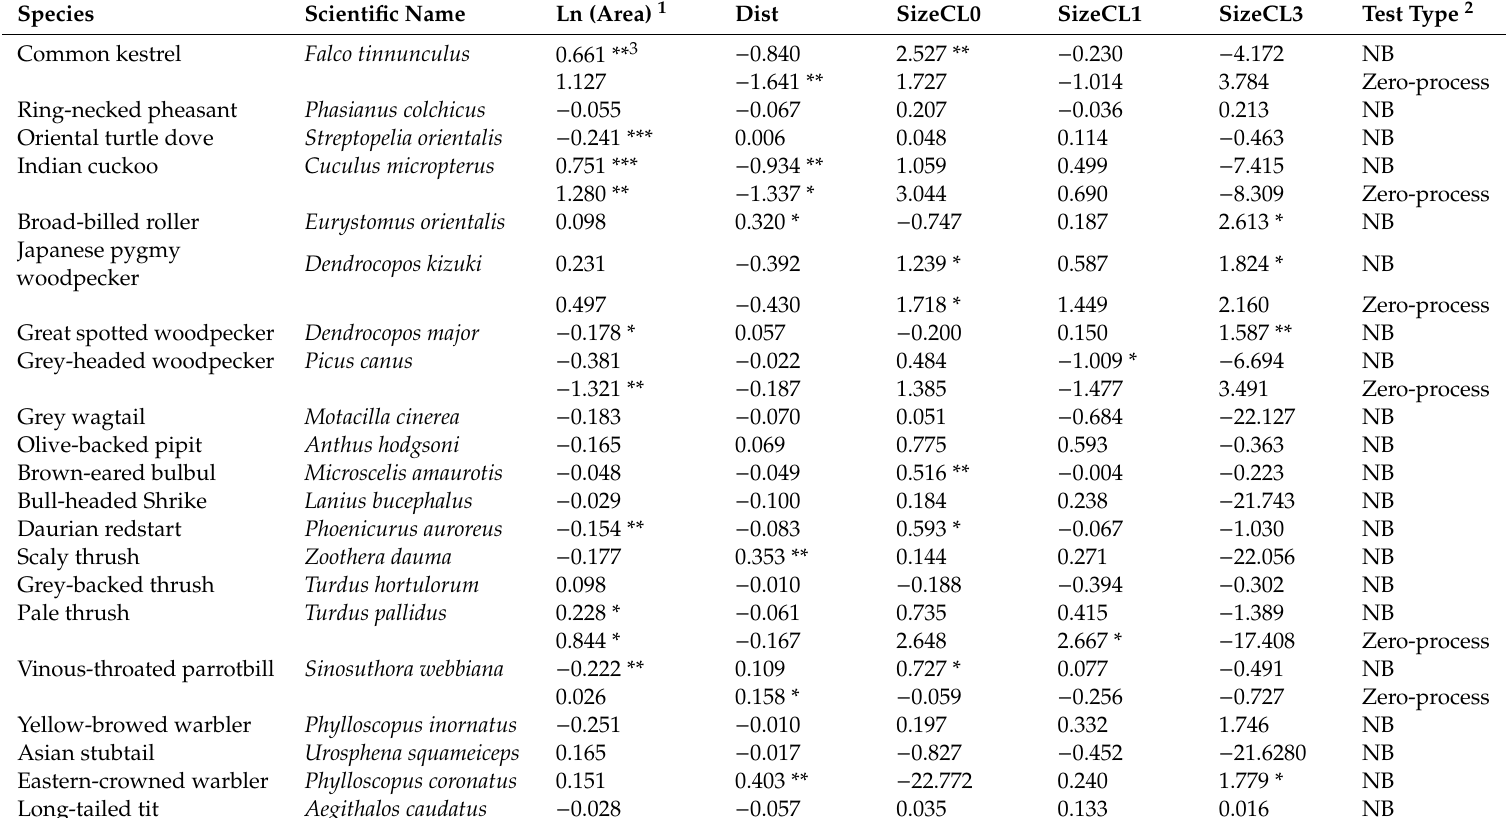
Table 3. Test result summary for individual species